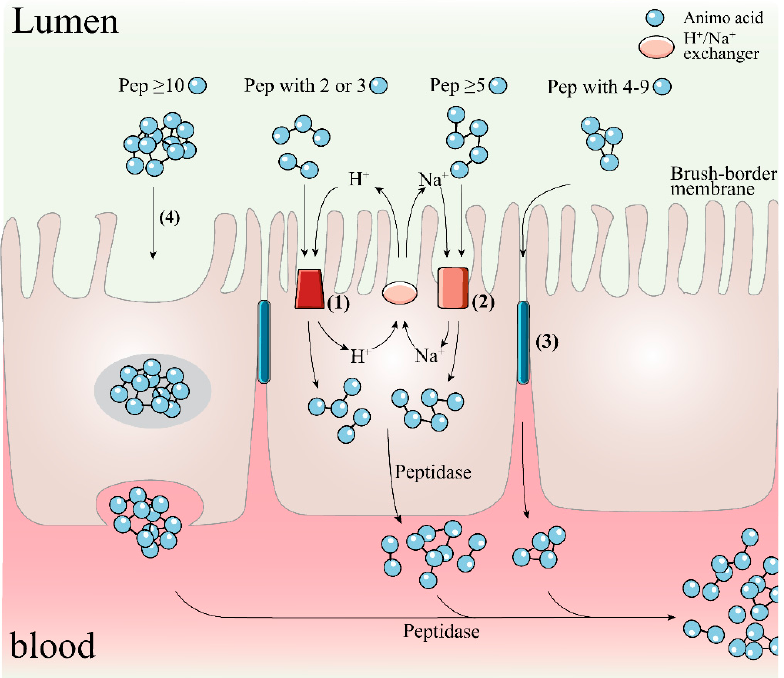
Figure 3. Underlying mechanisms of transcortical transport of peptides with diverse sizes. (1) H+- coupled PepT1 and 2; (2) Na+-coupled SOPT1 and 2; (3) paracellular; (4) transcytosis. Pep, peptide.